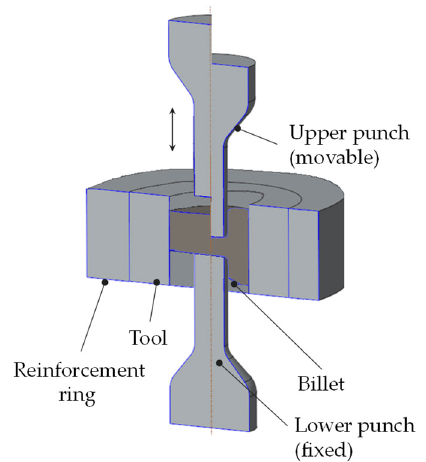
Figure 1. Schematic diagram of a double cup extrusion model.